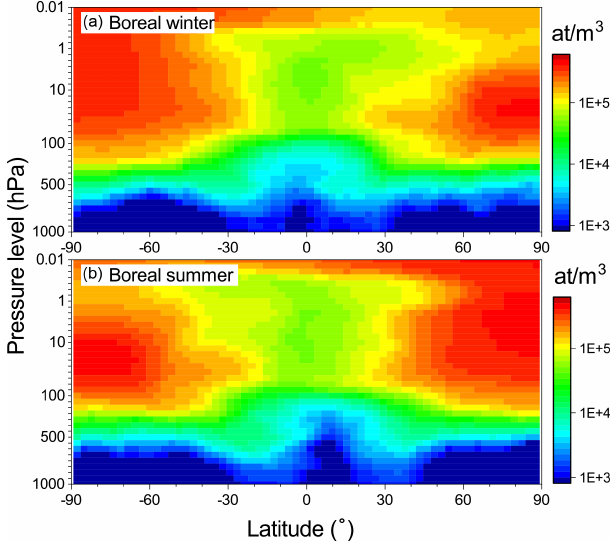
Figure 5. Modeled zonal mean concentrations of 7 Be during the boreal winter (a) and boreal summer (b) averaged over